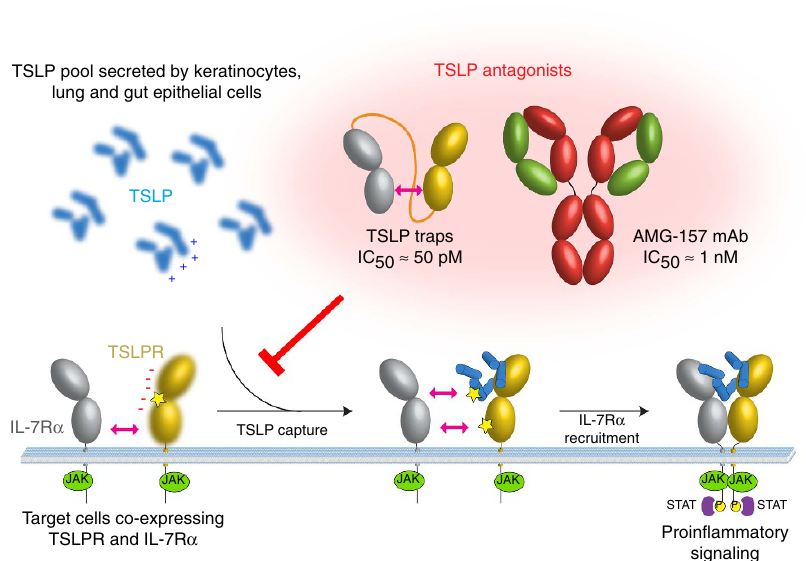
Figure 8 | Mechanistic recapitulation for the assembly and antagonism of the pro-inflammatory TSLP mediated complex. Following capture and rearrangement of TSLP by TSLPR at the cell surface, shared IL-7R a is recruited to initiate intracellular pro-inflammatory JAK-STATpathways. TSLP cytokine traps and anti-TSLP mAbs may represent effective strategies for therapeutic targeting of TSLP. Positive and negative signs represent the surface electrostatics of TSLP and TSLPR, respectively. Stars indicate site I, II and III. Left right arrows represent protein